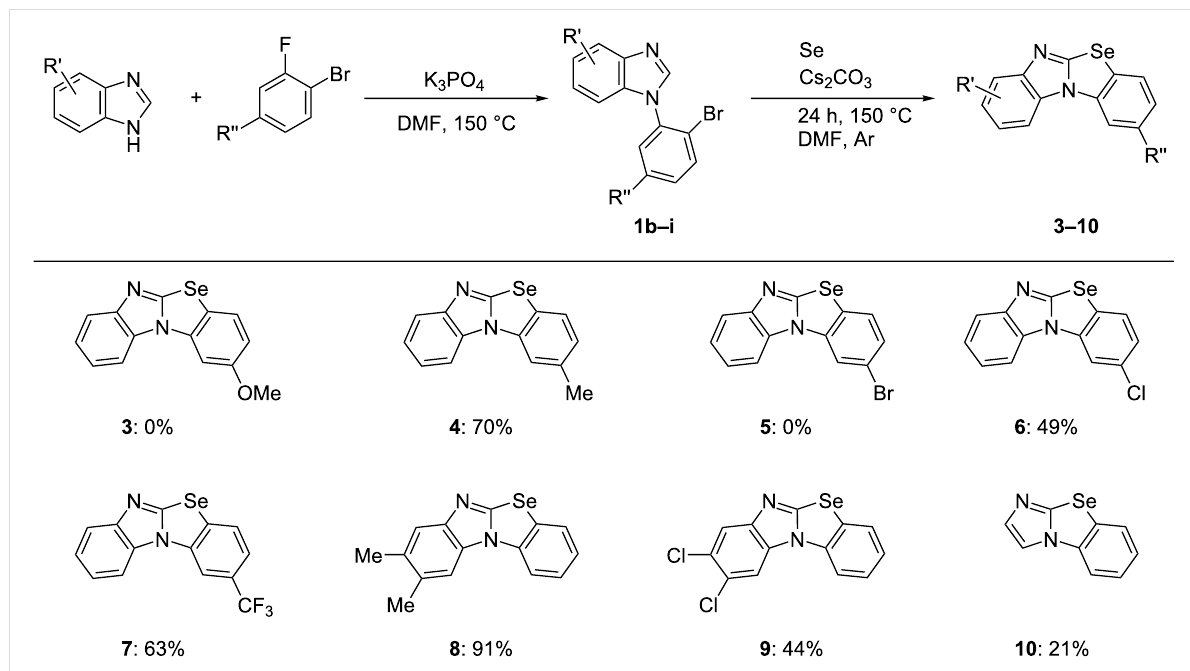
Figure 2: Cs 2 CO 3 -mediated cyclization of 1-(2-bromoaryl)imidazoles with Se. Reaction conditions: 1 (0.5 mmol), Se (1 mmol), Cs 2 CO 3 (1 mmol), DMF (1 mL), 150 °C, 24 h. Isolated yield.